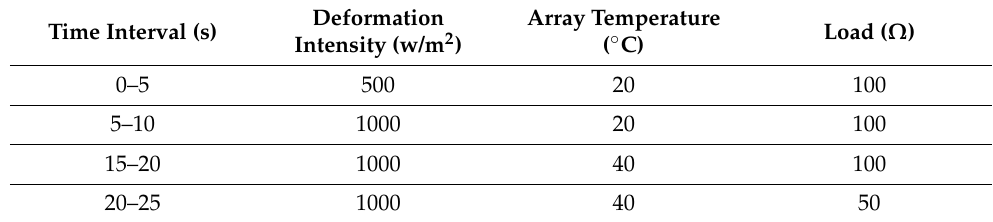
Figure 4. Power diagram in terms of piezoelectric yarn current under different intensities of deformations in different levels of 1 > 2 > 3 > 4. Table 1. Simulation conditions for comparison of control